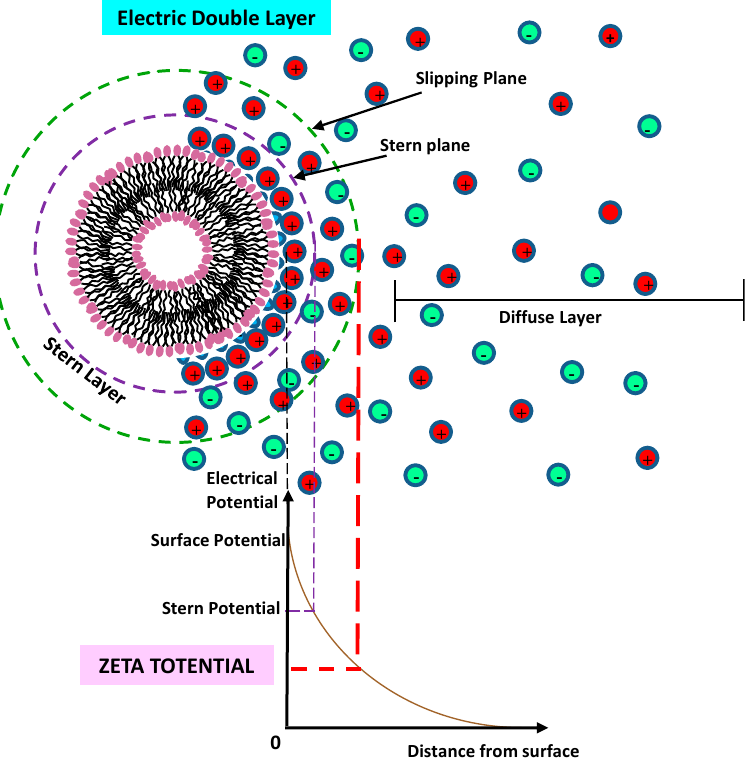
Figure 19. Diagram indicating the electrical potential as a function of the ionic concentration (and distance from the charged surface) of a liposome suspended in a dispersion medium.